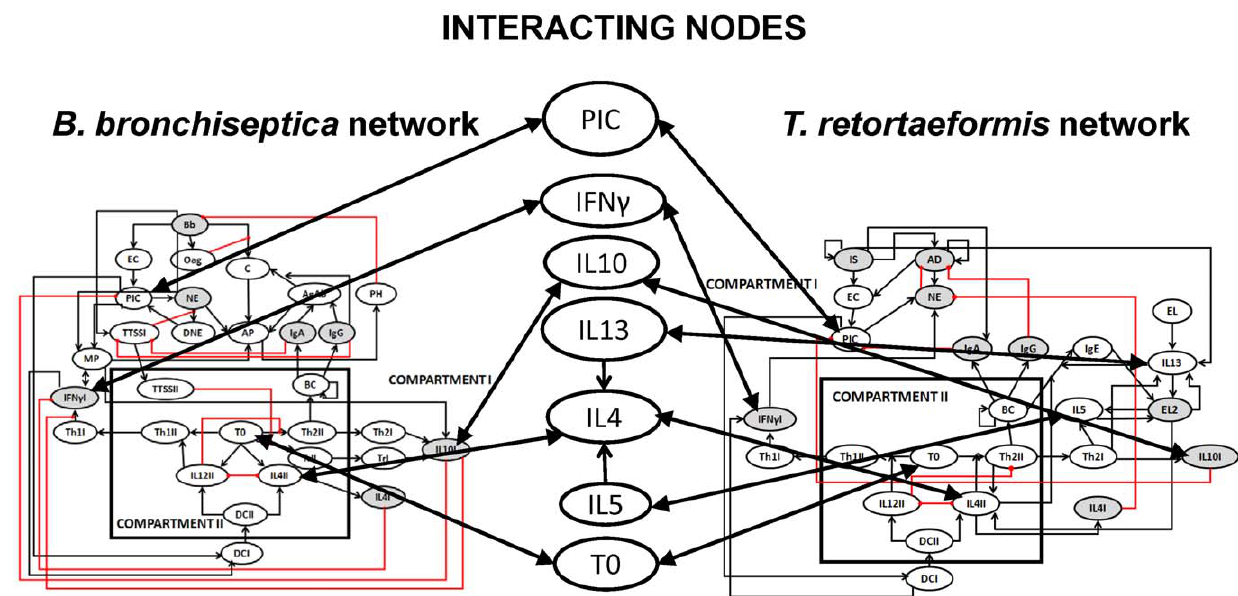
Figure 6. Network of immune components considered in the B.bronchiseptica-T.retortaeformis co-infection. Bi-directional black arrows indicate the influence of components from one network on the common cytokine pool and vice a versa.